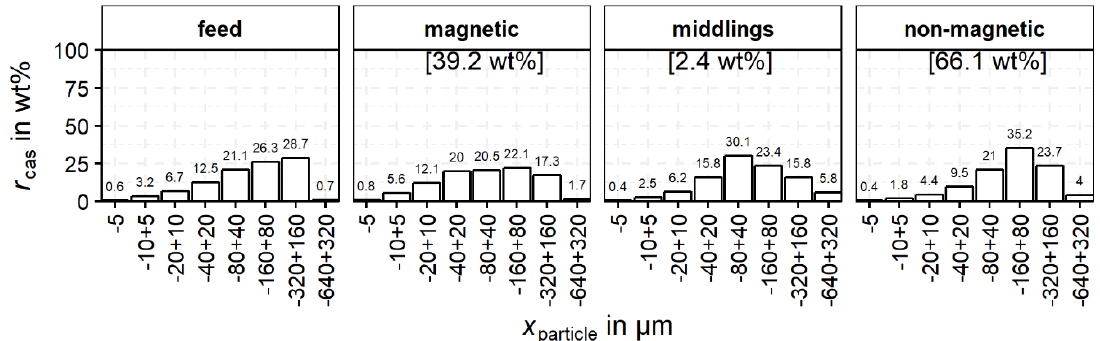
Figure 8. Distribution of cassiterite ( r cas ) in different size classes for feed and the products (values in brackets indicate distribution of cassiterite into the products from Table 5).